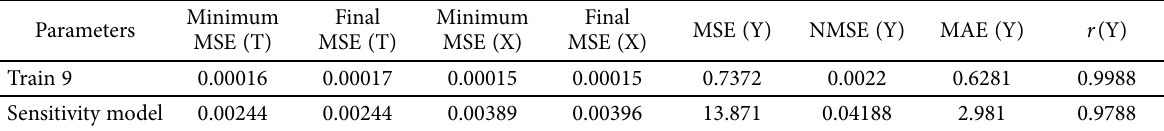
Fig. 6. Linear correlation between measured and simulated Fig. 4. Sensitivity analysis of considered variables traffic Table 6. Comparison between best ANN model (Train 9) and sensitivity model